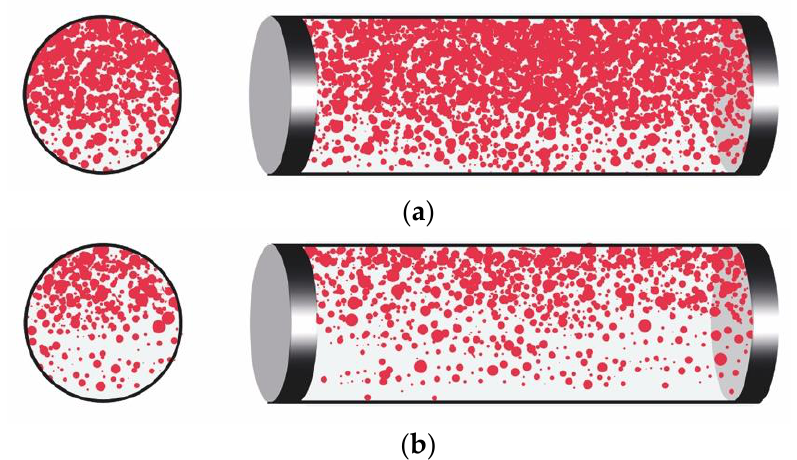
Figure A1. Dispersion of oil in water [Do/w]. ( a ) High oil fraction, ( b ) low oil fraction.